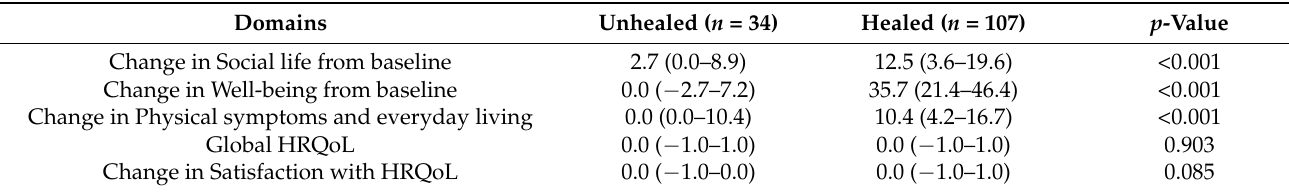
Table 4. Descriptive analysis of the sensitivity to change assessment of the Cardiff Wound Impact Schedule (CWIS) domains according to healing